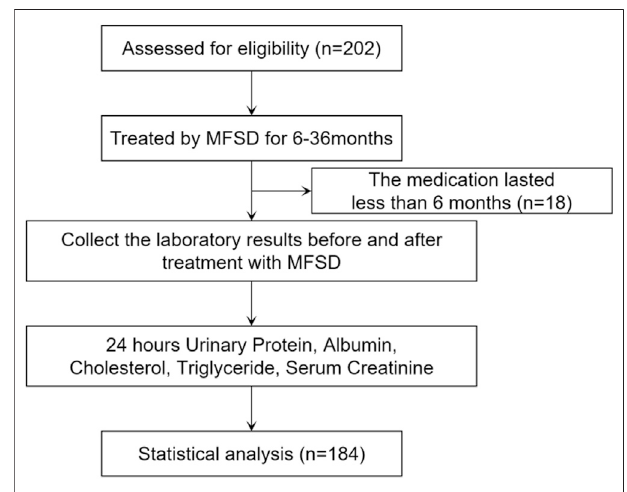
FIGURE 1 | Study fl ow